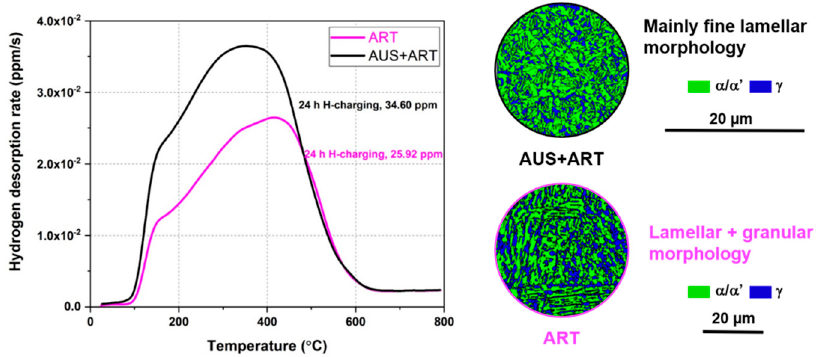
Figure 10. Hydrogen desorption rate as a function of temperature and the corresponding microstructural features.